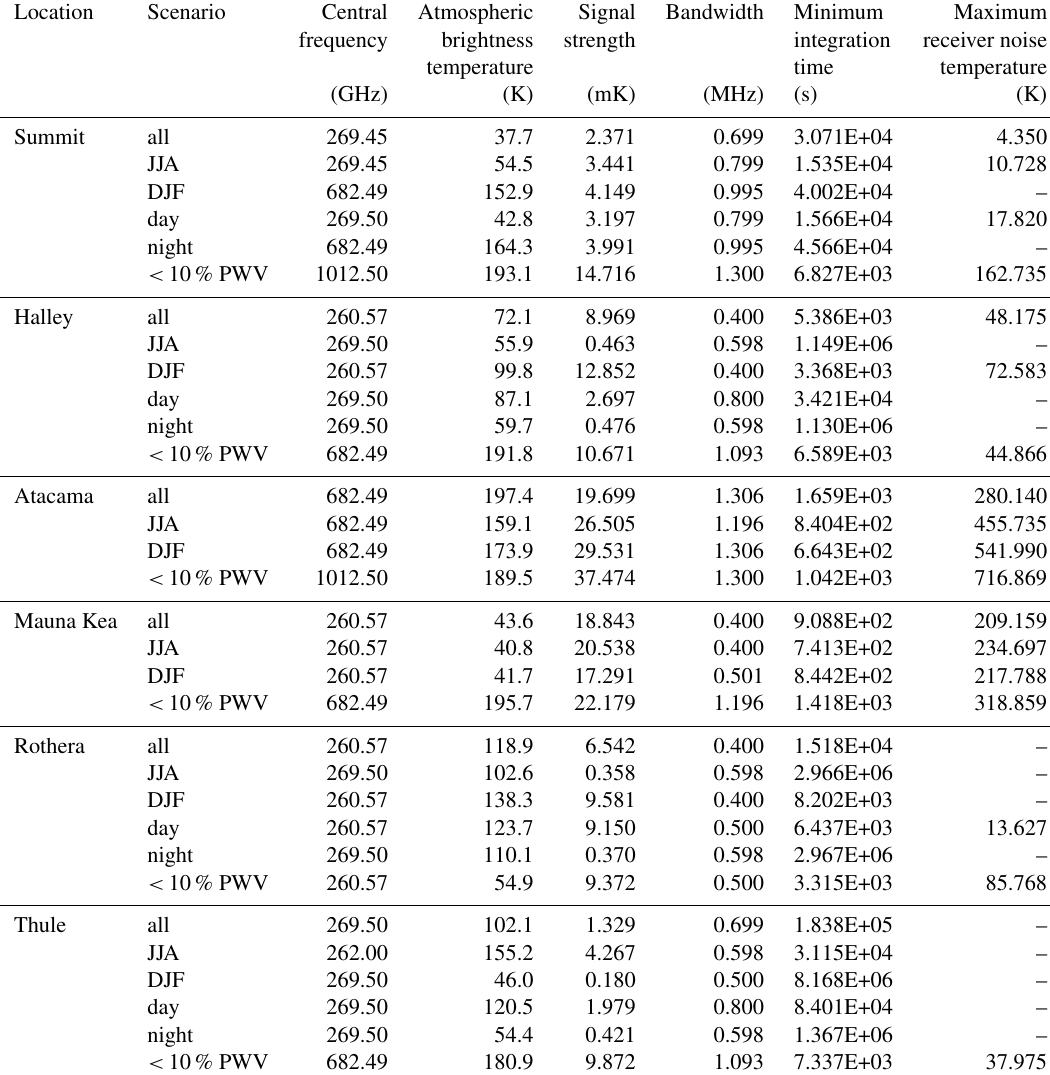
Table 7. As Table 5 but for HO 2 .